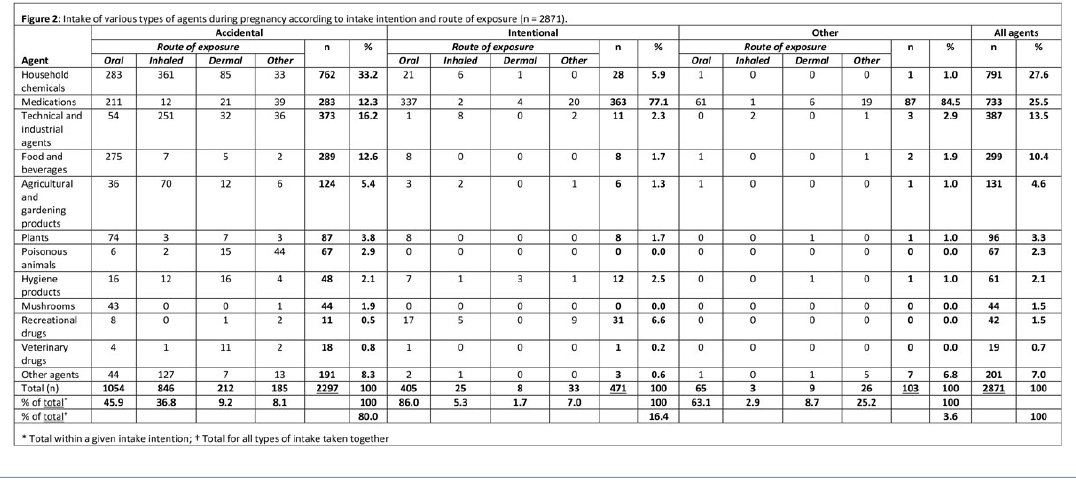
Figure 2: Intake of various types of agents during pregnancy according to intake intention and route of exposure (n = 2871).